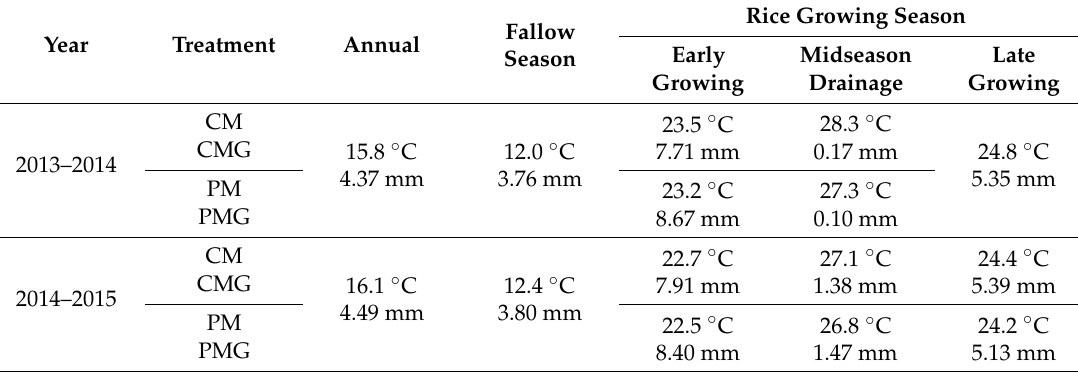
Table 4. Mean air temperature and mean daily precipitation in each